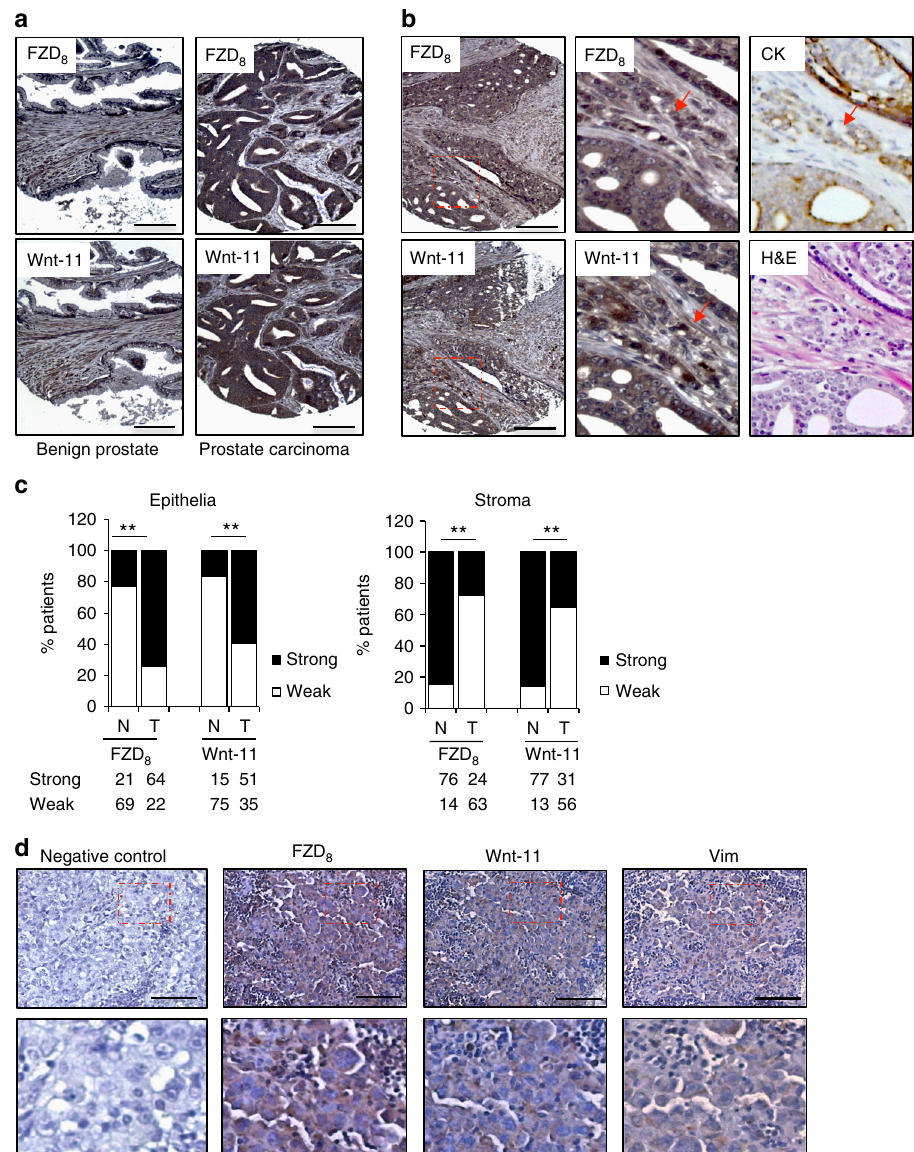
Fig. 5 FZD 8 and Wnt-11 expression correlates with prostate cancer progression. a Immunohistochemical staining of FZD 8 and Wnt-11 in adjacent sections of prostate cancer (Gleason 4 + 3) and an area of benign prostate from the same patient; scale bar 25 μ m. b Immunohistochemical staining of FZD 8 and Wnt-11 in a section of prostate cancer (Gleason 4 + 3) from another patient; scale bar 25 μ m. High magni fi cation images for FZD 8 , Wnt-11, epithelial pan- cytokeratin (CK), and H&E are also shown. Arrows show disseminated tumor cells positive for FZD 8 , Wnt-11, and epithelial cytokeratins. c Strati fi cation of FZD 8 and Wnt-11 expression in cancer (T) and benign (N) epithelia and stroma (** p < 0.001 by Pearson Chi-square test with correction). d Immunohistochemical staining for FZD 8 , Wnt-11, and vimentin in sections of a PC-3M cell lymph node metastasis from a mouse orthotopic xenograft; scale bars 50 µ m. Squares highlight regions shown at higher magni fi cation